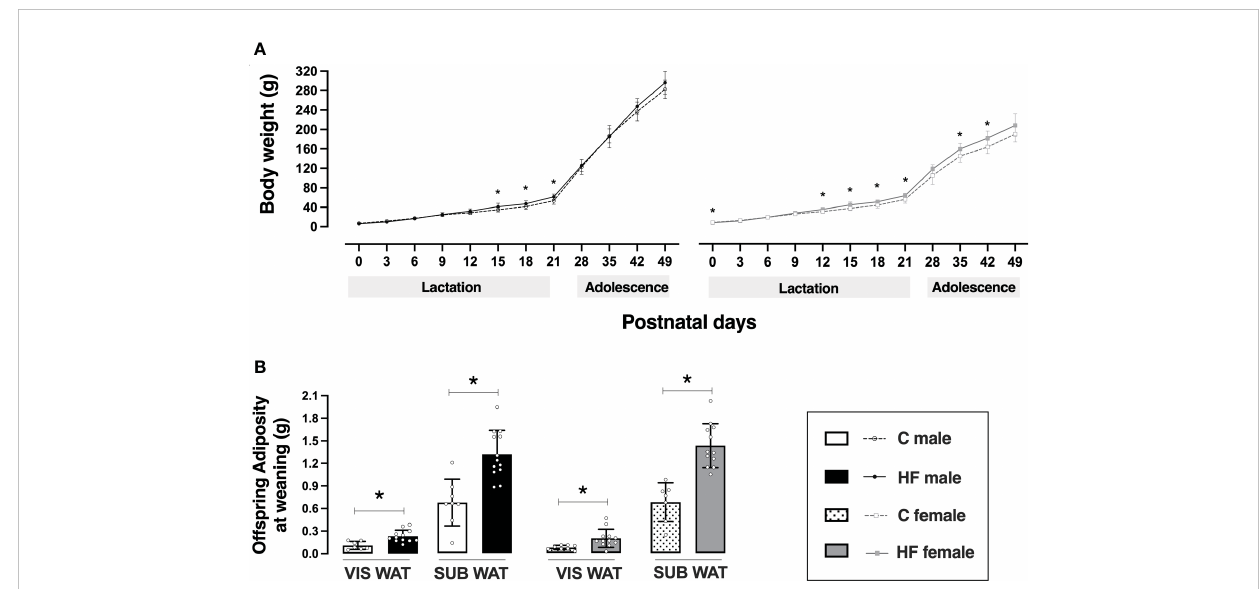
FIGURE 3 Effect of maternal high-fat (HF) diet on offspring body weight and adiposity in the early life. (A) Body weight and (B) visceral (VIS) and subcutaneous (SUB) adiposity of control (C) and HF male and female offspring at weaning (postnatal day 21). Data are presented as mean ± standard deviation and statistically signi fi cant differences were determined by two-way ANOVA followed by Bonferroni test. *p < 0.05